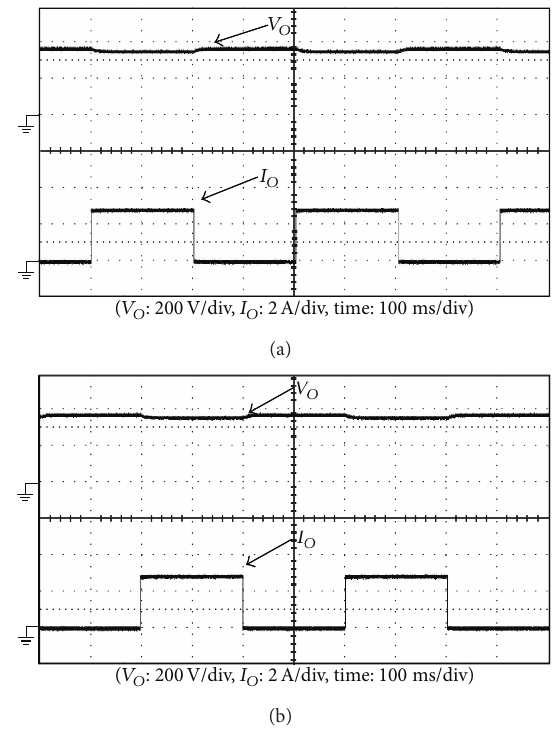
Figure 10: Output voltage 𝑉 𝑂 and output current 𝐼 𝑂 under step-load changes between 0% and 100% of the full load of the active clamp interleaved boost converter (a) with the single-capacitor snubber and (b) with the boost type